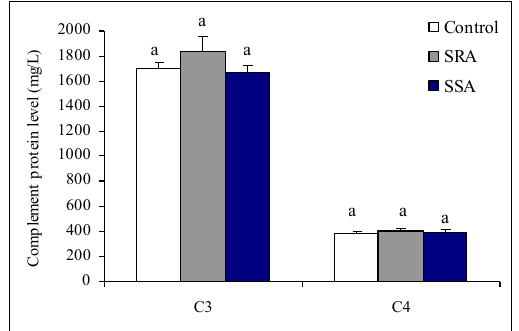
Fig. (2): Complement proteins level among SSA (n=28) and SRA (n=27) patients. Values are (mean ± SEM). No significant difference among groups, P>0.05 analyzed by